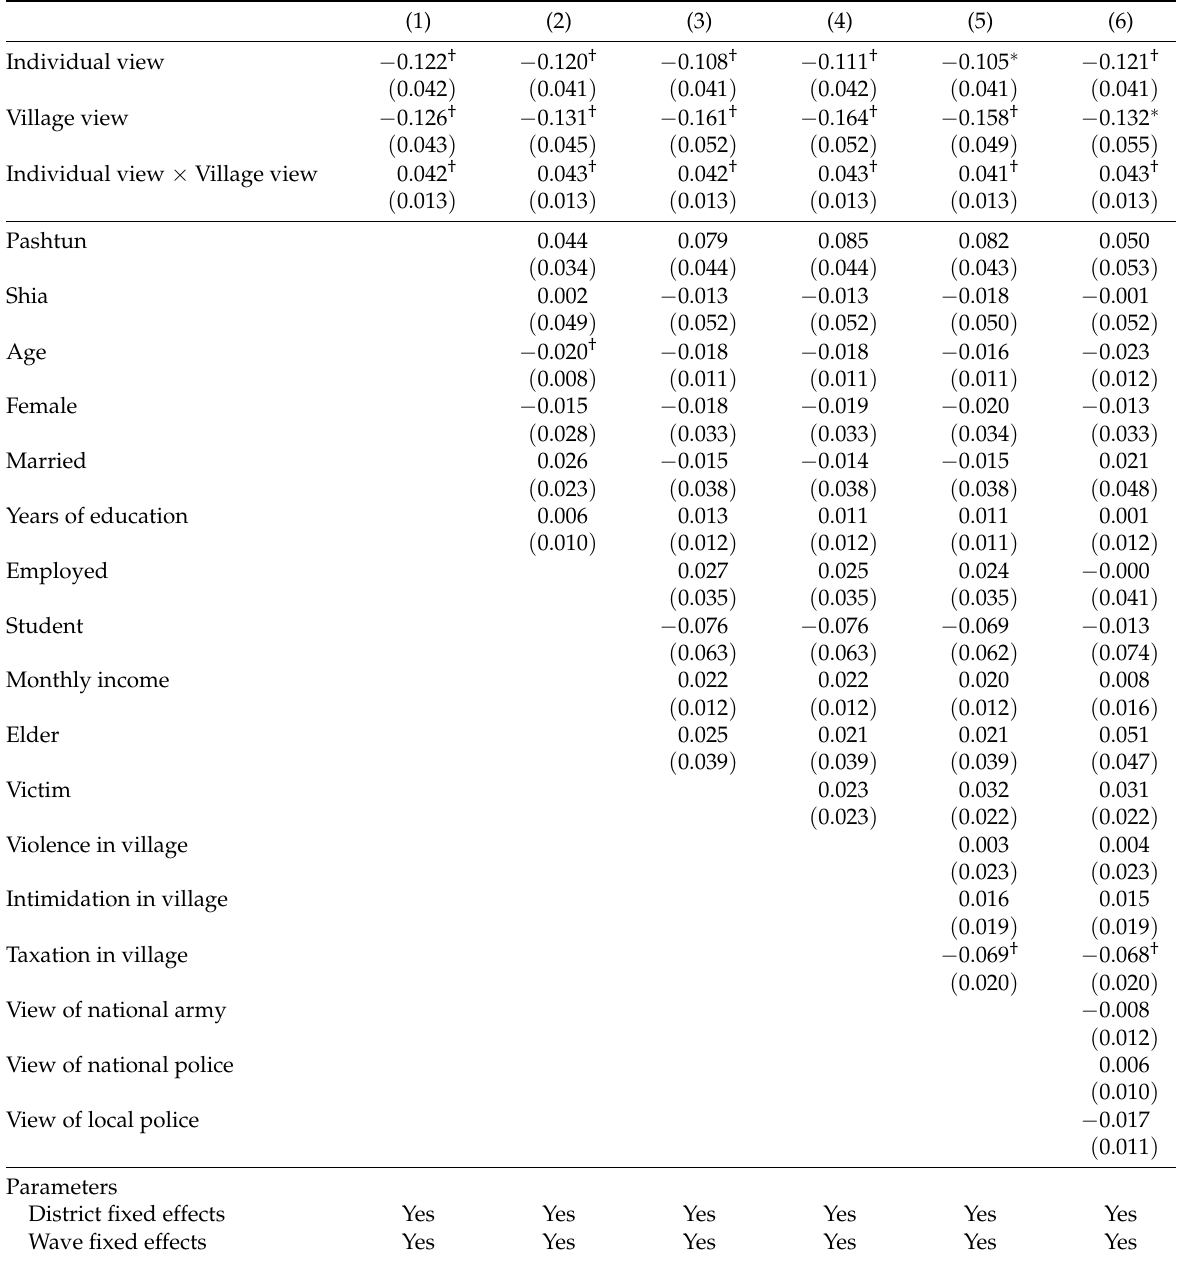
Table 4: Association between individual and village views of the Taliban and whether individual reports wrongdoing (two-stage